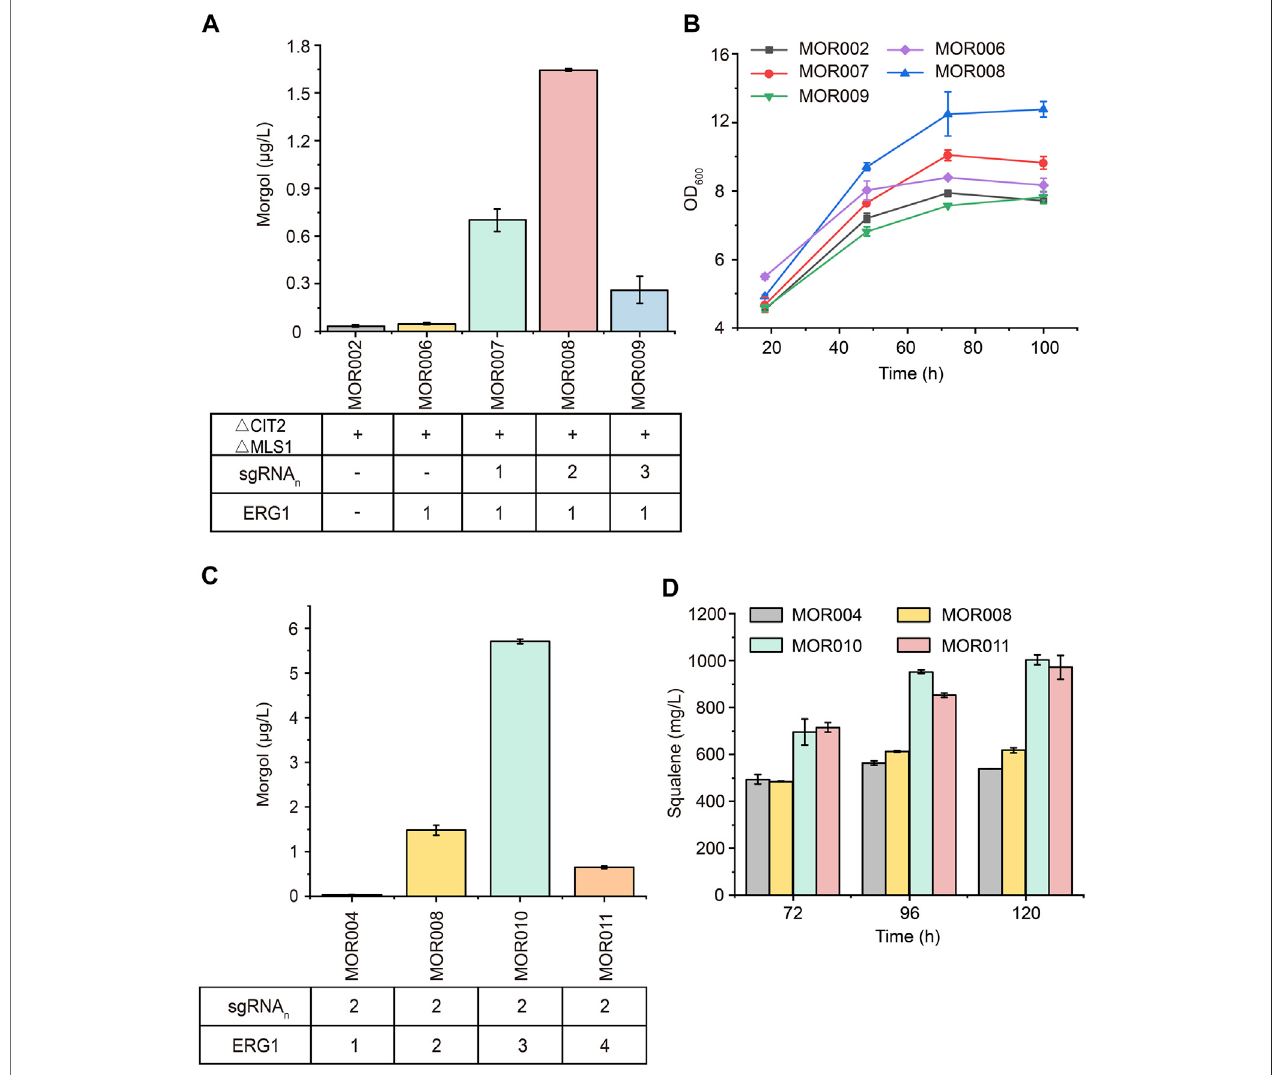
FIGURE5|Effectsofmulticopyexpressionof ERG1 onmogrol.(A) MogrolproductioninMOR007toMOR009compared toMOR002andMOR006 (B) Cell growth curves of engineered strains that overexpressed ERG1 in YPD medium. (C,D) Mogrol (C) and squalene (D) production after multicopy genome integration of ERG1 . Error bars represent the SD of biological triplicates ( n =